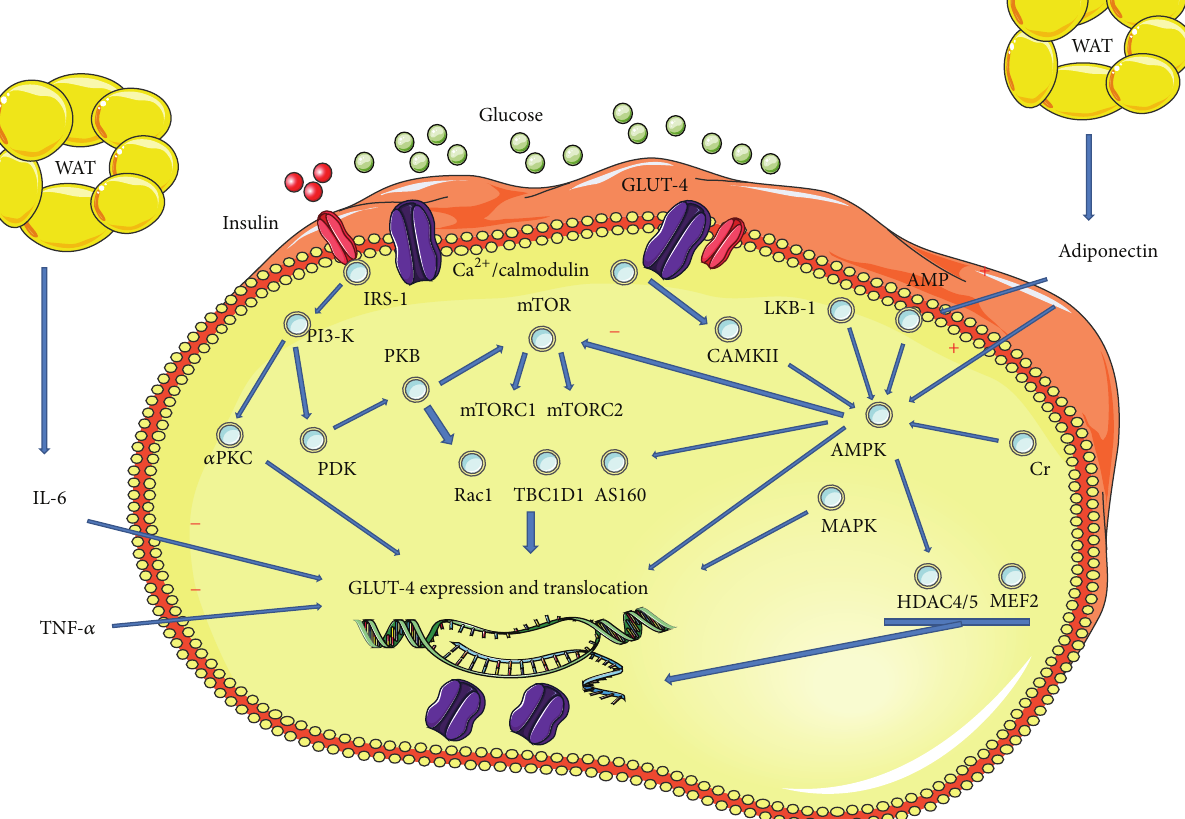
Figure 1: Interaction of important key players in exercise mediated glucose uptake of human muscle cells. A proposed model for the key players in glucose transport after physical exercise. 𝛼 PKC, atypical PKC; AMP, adenosine monophosphate; AMPK, AMP-activated protein kinase; AS160, Akt substrate of 160kDa; Ca, calcium; CaMKII, Ca 2+ /calmodulin-dependent protein kinase 2; Cr, creatine; GLUT-4, glucose transporter4;HDAC4/5,histonedeacetylase4/5;IL-6,interleukin6;IRS-1,insulinreceptorsubstrate1;LKB-1,liverkinaseB1;MEF2,myocyte enhancer factor-2; MAPK, mitogen-activated protein kinases; mTOR, mammalian target of rapamycin (C1 complex 1 and C2 complex 2); PDK, phosphoinositide-dependent kinase; PI3-K, phosphoinositide 3-kinase; PKB, protein kinase B; Rac1, ras-related C3 botulinum toxin substrate 1; TBC1D1, TBC1 domain family member 1; TNF- 𝛼 , tumor necrosis factor alpha; WAT, white adipose